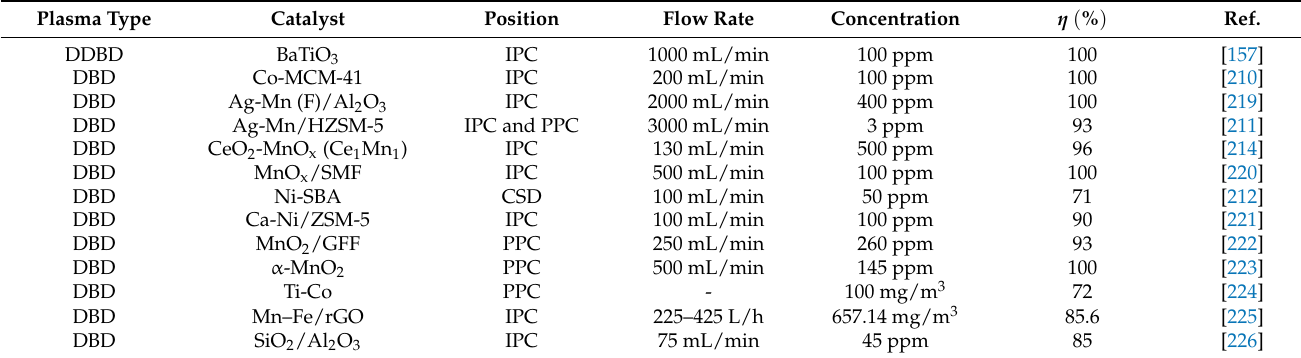
Table 5. Summary of the plasma-catalytic toluene